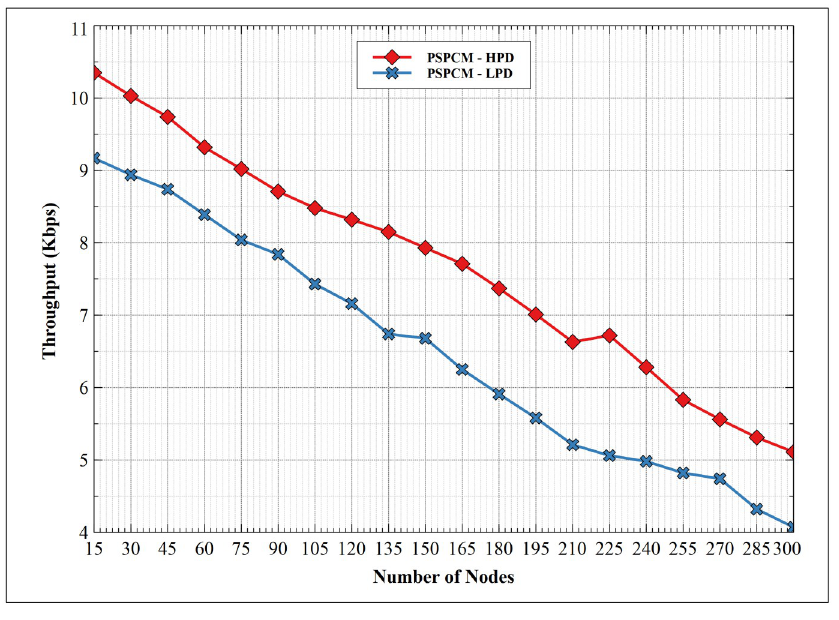
Fig 14. Throughput—HPD vs